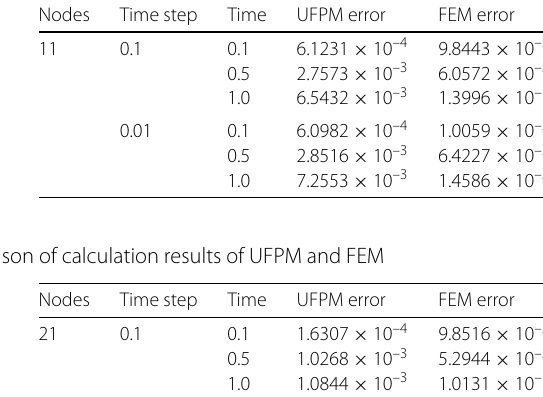
Table 3 Comparison of calculation results of UFPM and FEM Nodes Time step Time UFPM error FEM error